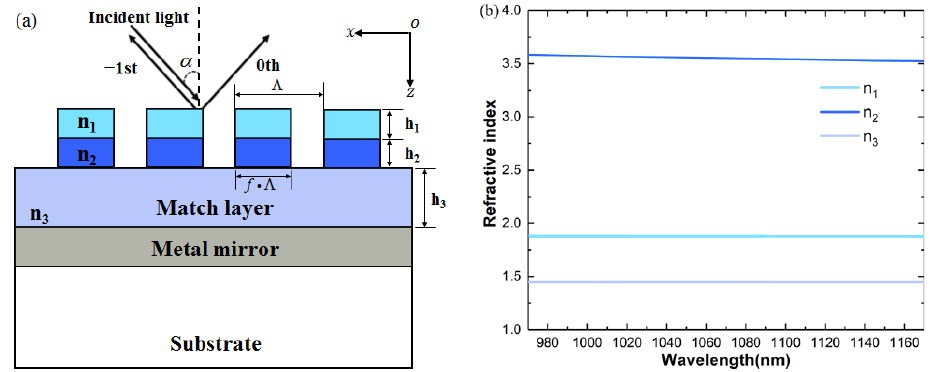
Figure 1. ( a ) Schematic diagram of the grating and ( b ) the refractive indices of the material of the dielectric layers.